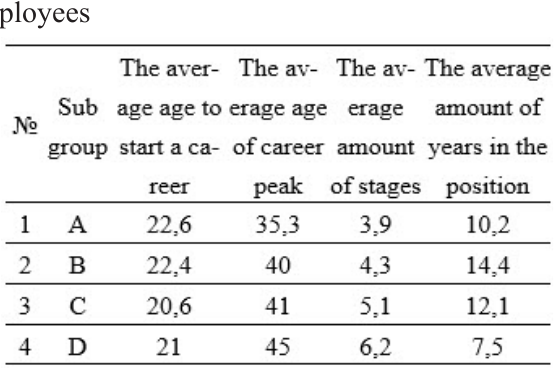
Table 1. The analysis of the structural